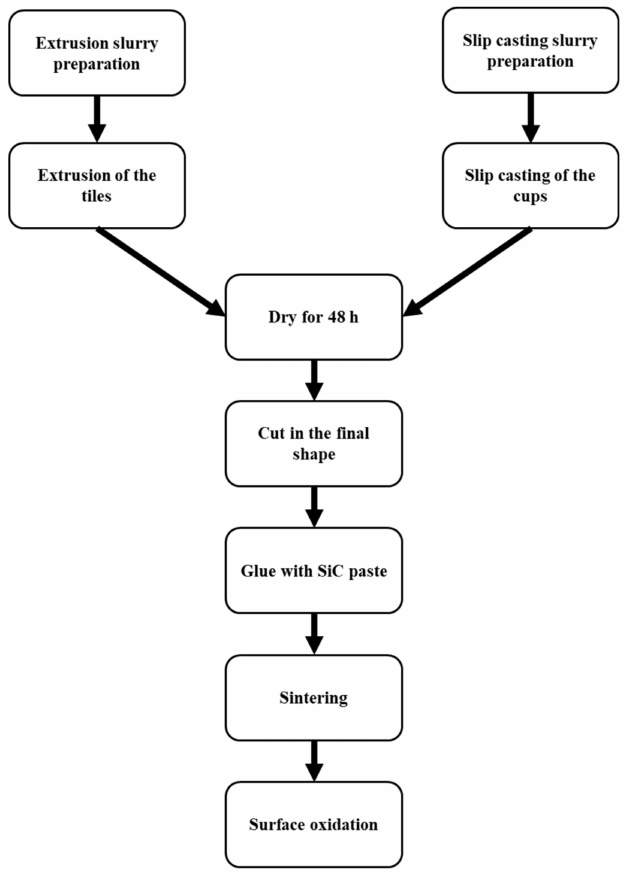
Figure 1. Schematic representation of the process flow for all-SiC solar receivers. Tiles and cups were characterized by Scanning electron microscope, FlexSEM 1000 (Hi- tachi GmbH, Stockholm, Sweden) and Hg porosimetry (Poremaster© GT, Quantachrome Instruments, Leipzing, Germany) to check their stability.